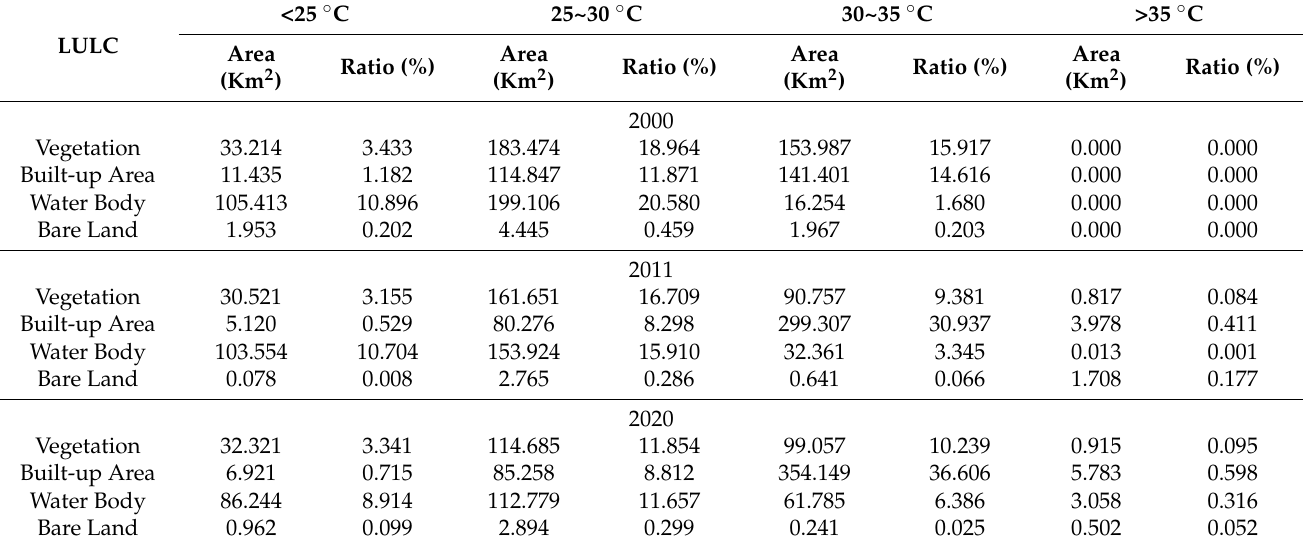
Table 5. Cross-linkage of LST variation over different LULC